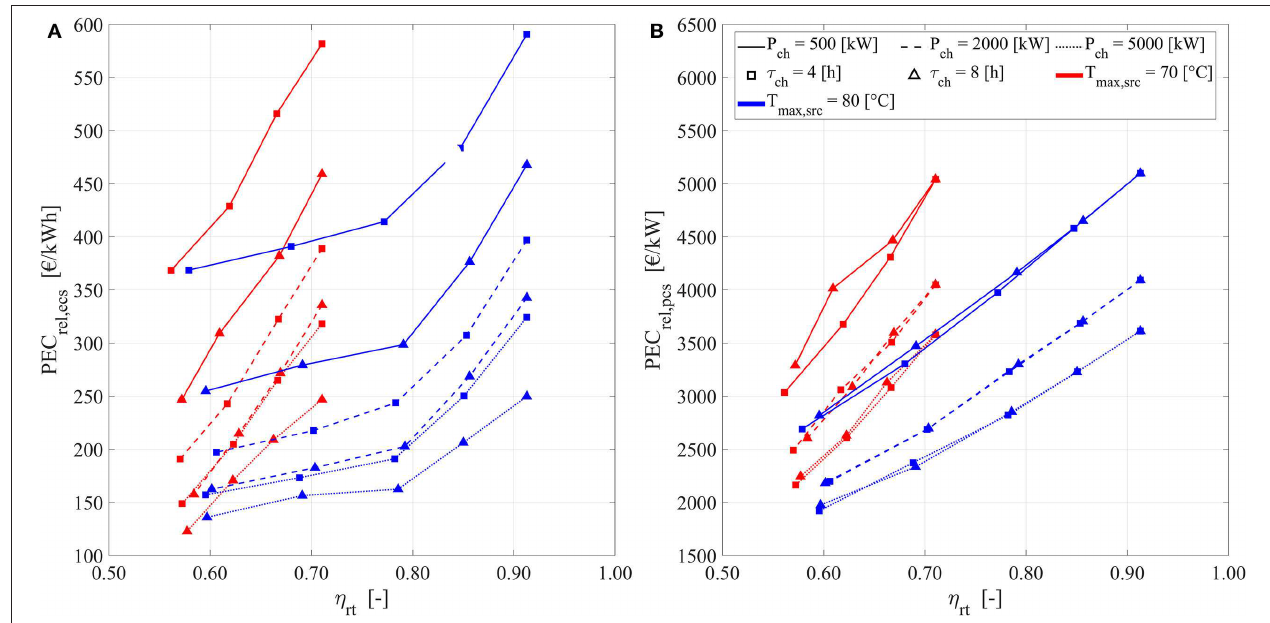
FIGURE 5 | Relative costs in e /kW and e /kWh as a function of storage size, duration, and heat source temperature values. (A) Relative capacity-related cost e /kWh. (B) Relative power-related cost e